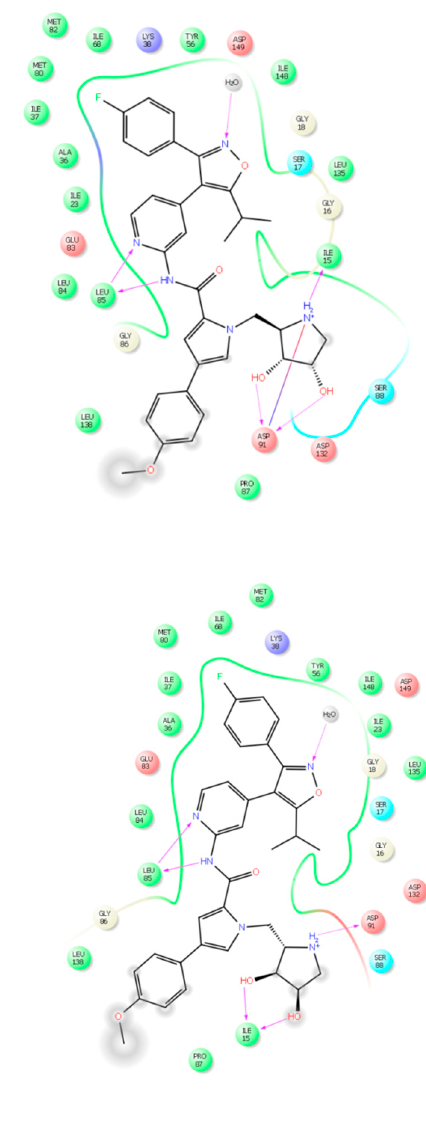
Figure 4. Predicted binding modes (left) and their corresponding ligand ‐ interaction ‐ diagrams (right) of designed enantiomers 29d ( A ) and 29e ( B ) (grey sticks) within the ATP binding site of protein kinase CK1 δ (grey lines, pdb 3UZP [41]); potential hydrogen bond interactions, yellow dashed ‐ lines.